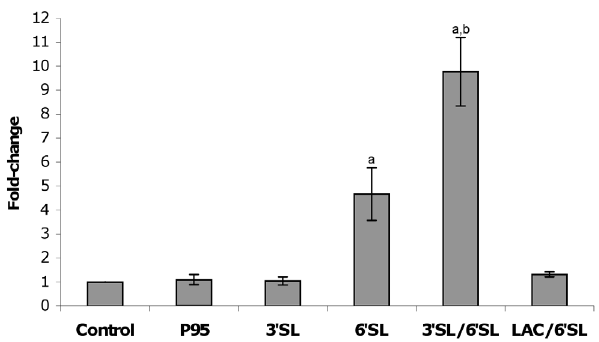
Figure 1. Screening oligosaccharides for their ability to influence adhesion of B.longum subsp. infantis ATCC 15697 to HT-29 cells. Abbreviations: P95 - Beneo Orafti P95; 3 9 SL - 3 9 sialyllac- tose; 6 9 SL –6 9 sialyllactose; Lac - lactose. Non-supplemented